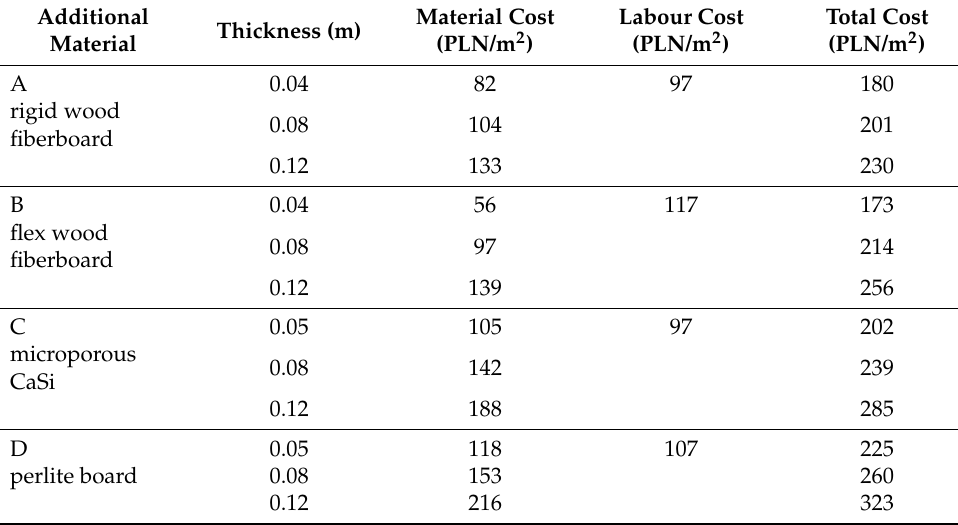
Table 4. Cost of additional thickness of internal retrofitting